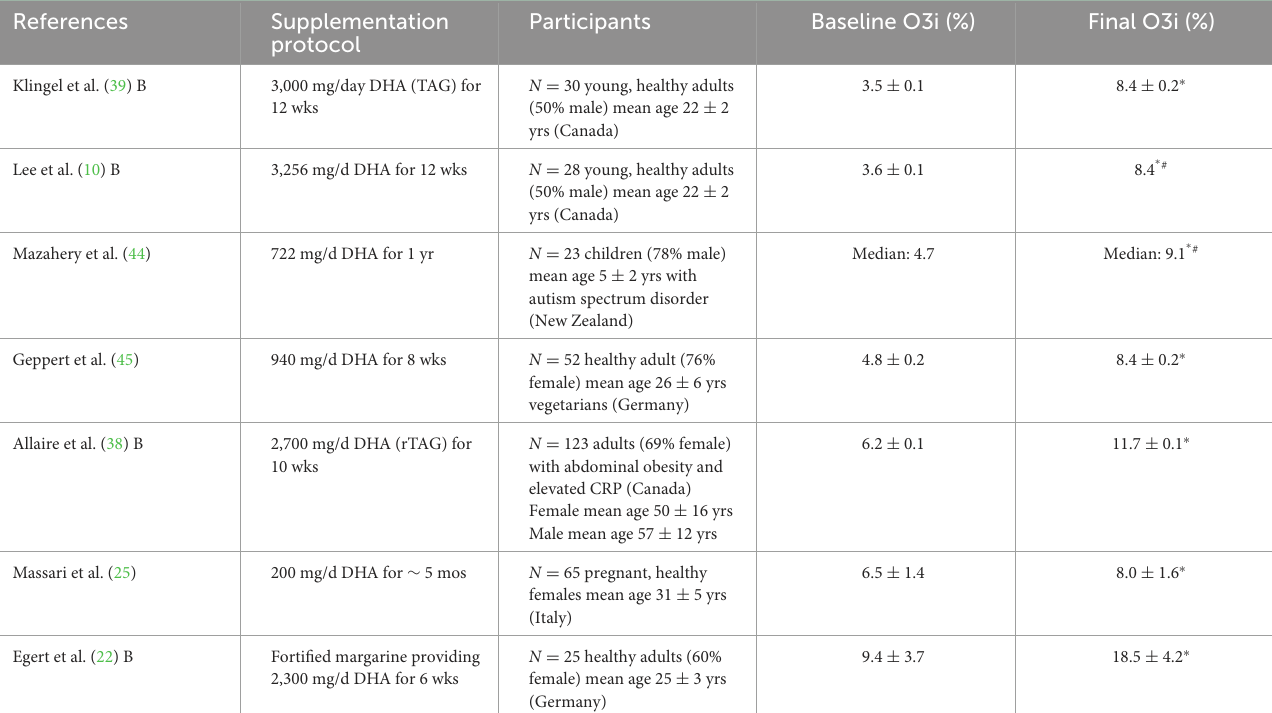
TABLE 3 Docosahexanoic acid (DHA) supplementation protocols and omega-3 index